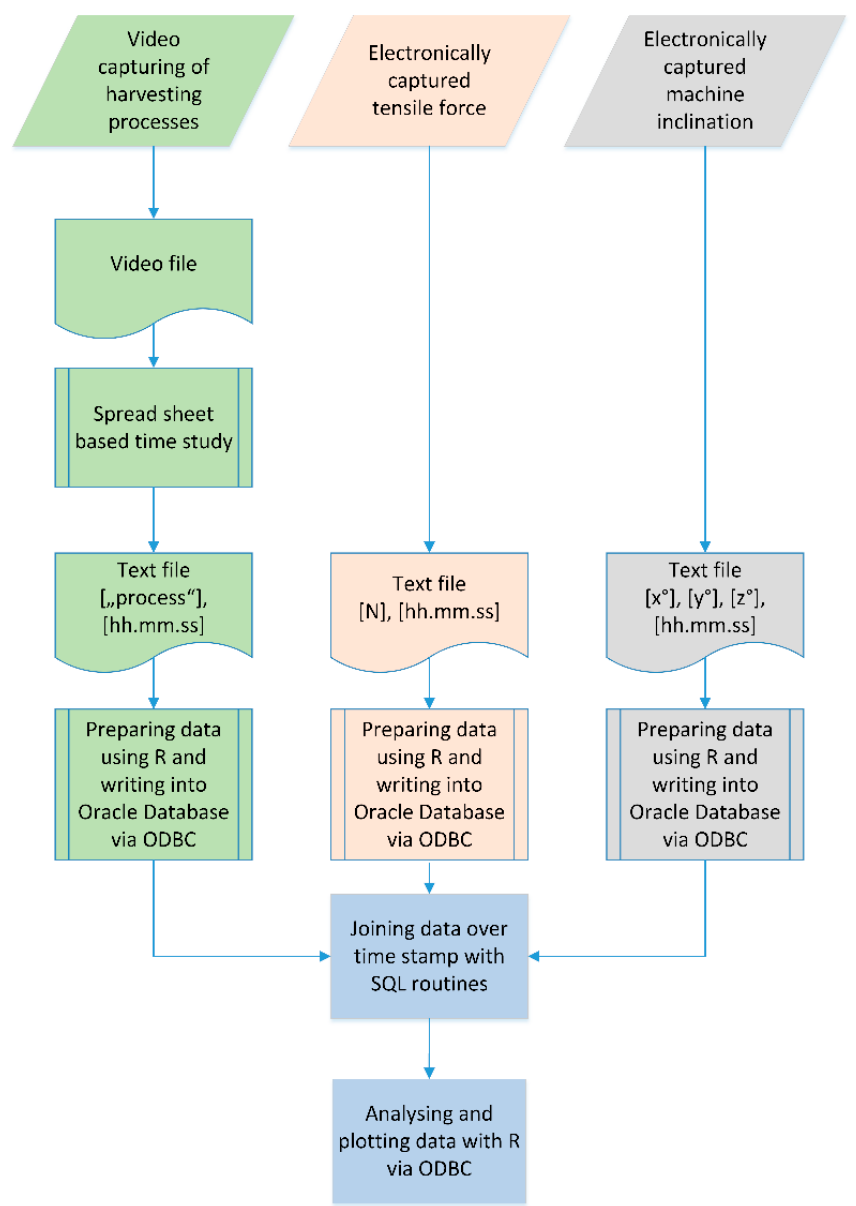
Figure 6. The developed workflow for preparing data from the time study, the tensile force measurements, and from the sensor recording machine inclination for writing via an Open Database Connectivity (ODBC) into the database and joined using the time stamps for further analysis. SQL: structured query language.